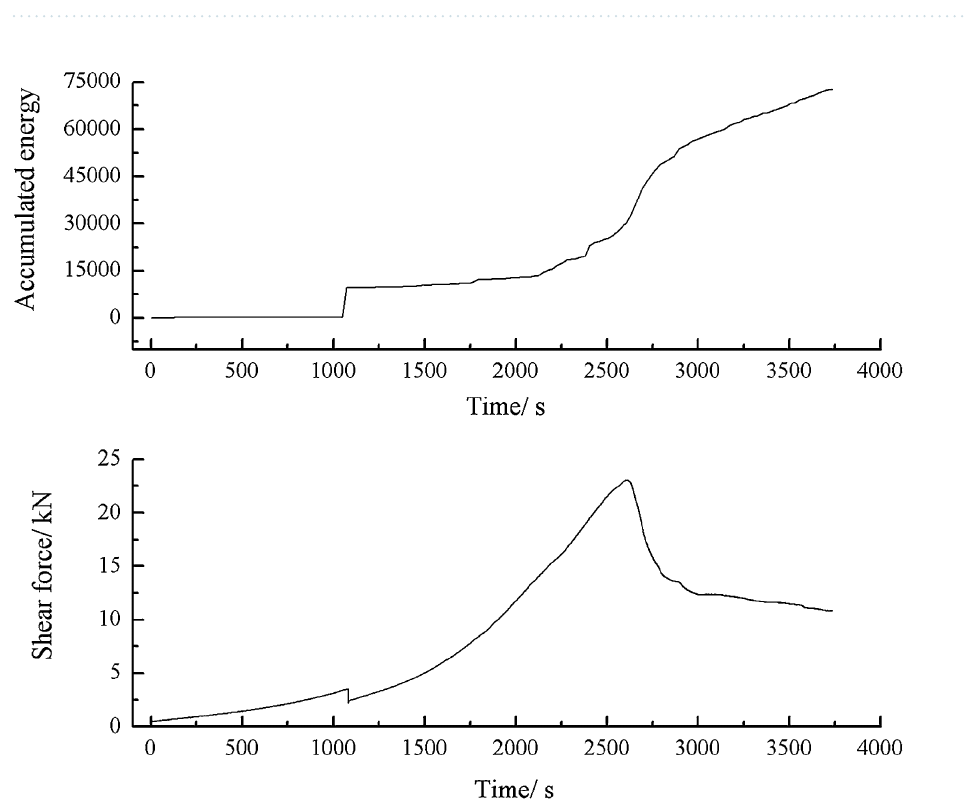
Figure 53. Shear stress–time and cumulative energy-time curves for a specimen containing 1–2.56 mm sand particles (one grain size